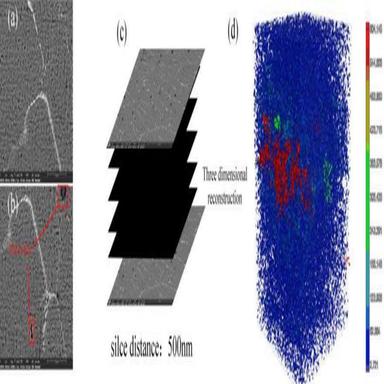
Characterization and 3-D reconstruction of micro-voids: (a) and (b) the SEM images of micro-voids, (c) a schematic diagram of a three-dimensional reconstruction of computed tomography and (d) 3D spatial distribution map of micro-voids.